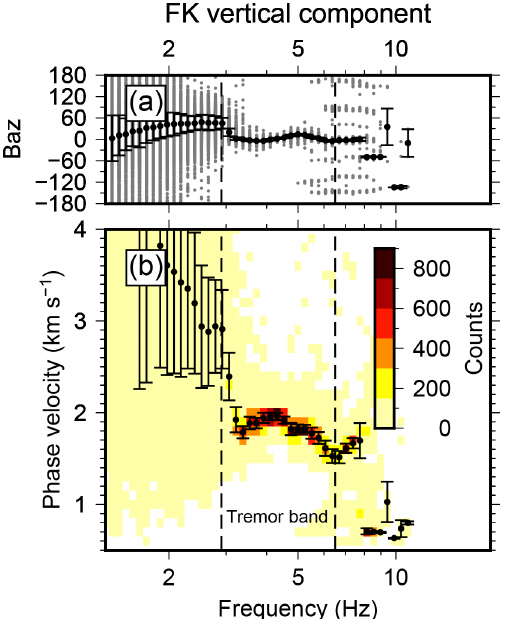
Figure C1. Example of FK analysis of vertical components of KBSA array for a tremor occurring between 12 May 2016 03:02:00UTC and 12 May 2016 06:17:00UTC. (a) All back- azimuth (baz) measurements at maximum beam power and with coherency (normalized beam power) > 0 . 7 for 600s long time windows during tremor occurrence (gray symbols) and median with median deviation (black). (b) Color-coded histogram (counts) of phase velocity measurements for same time windows as in panel (a) and median with median deviation.